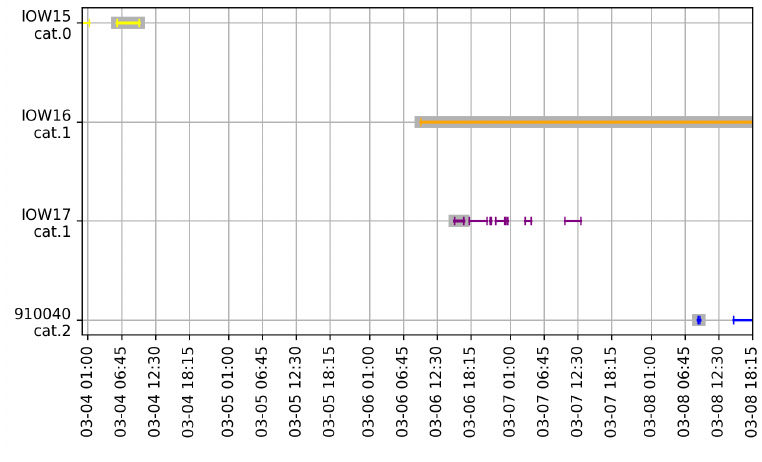
Figure 20. Query result for Query